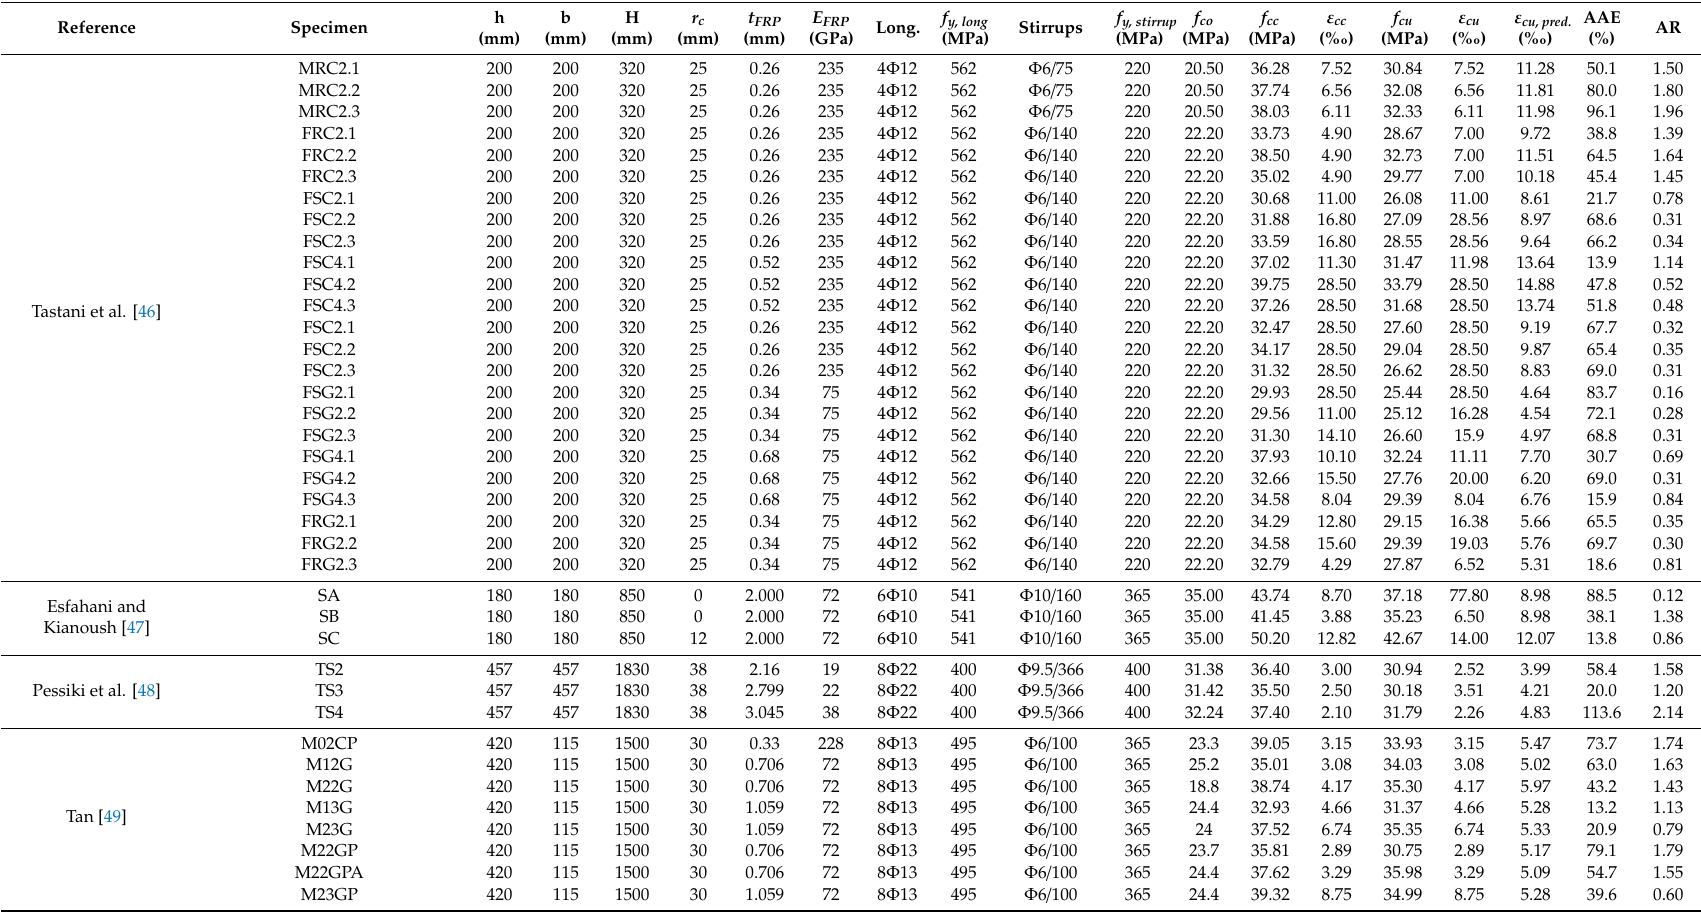
Table 2. Geometrical and mechanical data of 130 RC square and rectangular columns under monotonic axial